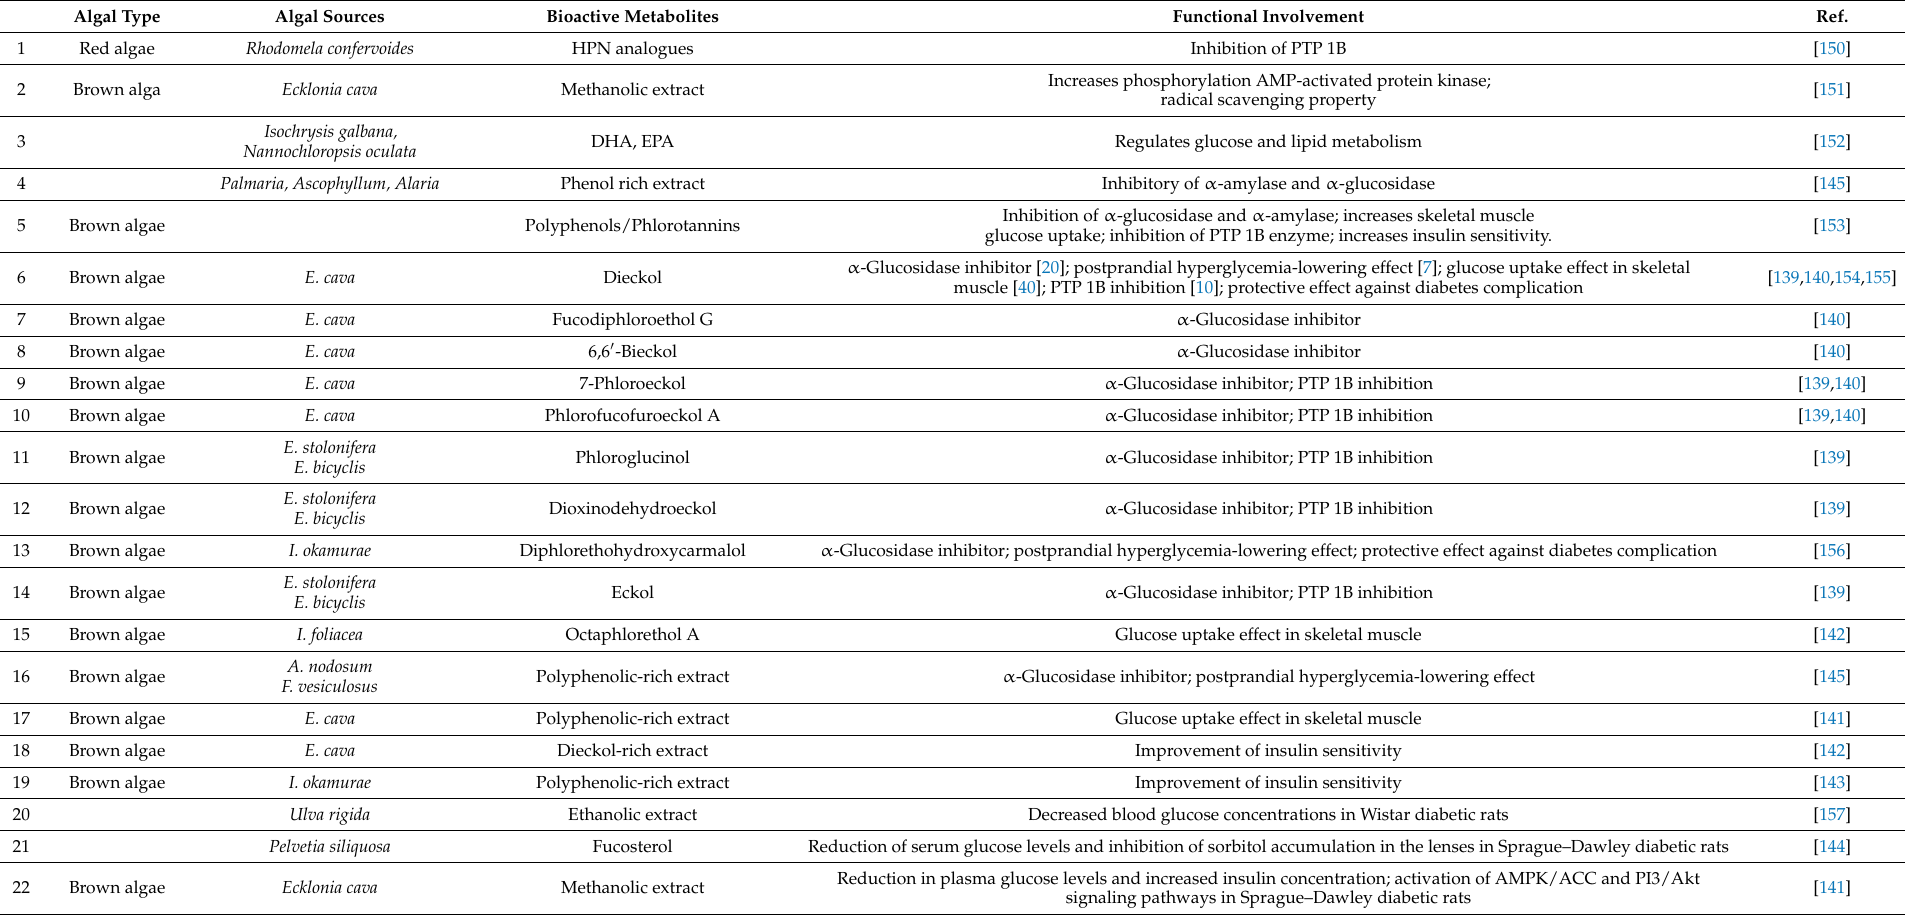
Table 2. Marine algal bioactive metabolites and their functional role in